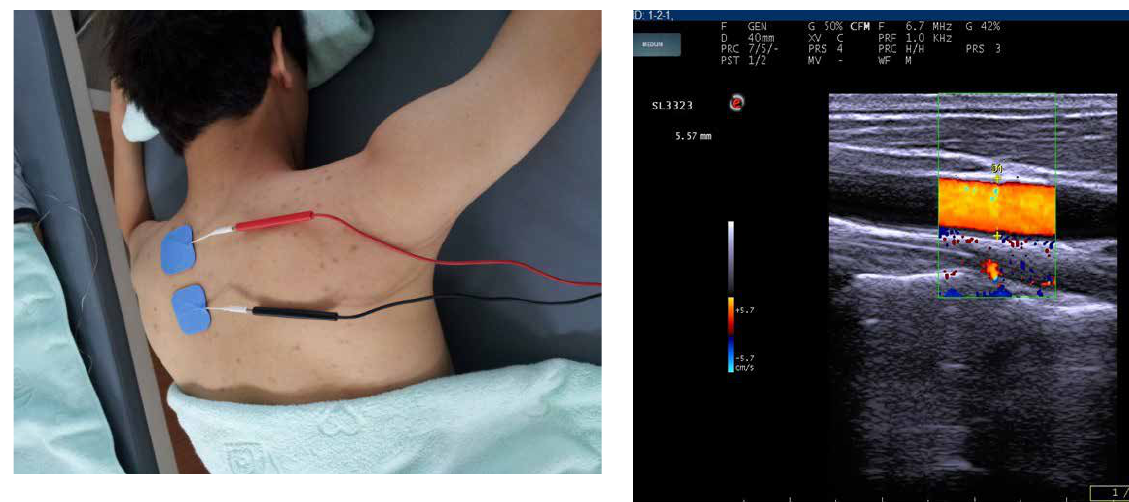
Figure 1: Method of IFC electrode application